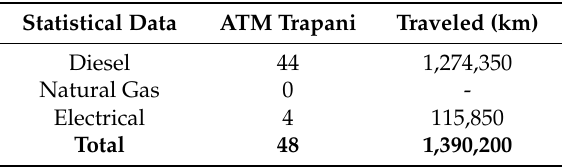
Table 1. Comparison between theory and